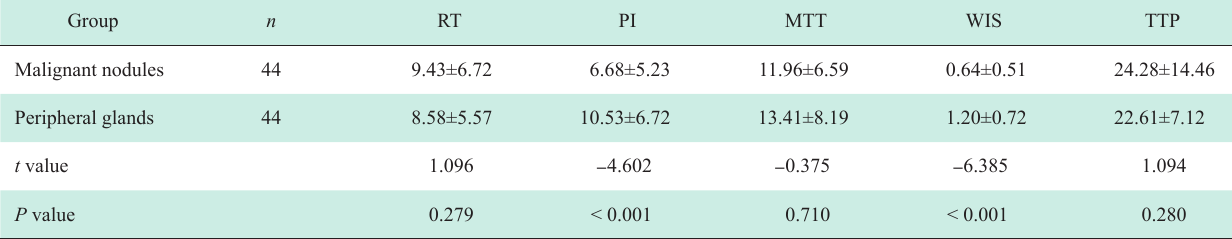
Table 2 The comparison of quantitative CEUS parameters between thyroid malignant nodules and peripheral glands (Mean ± SD) Group n RT